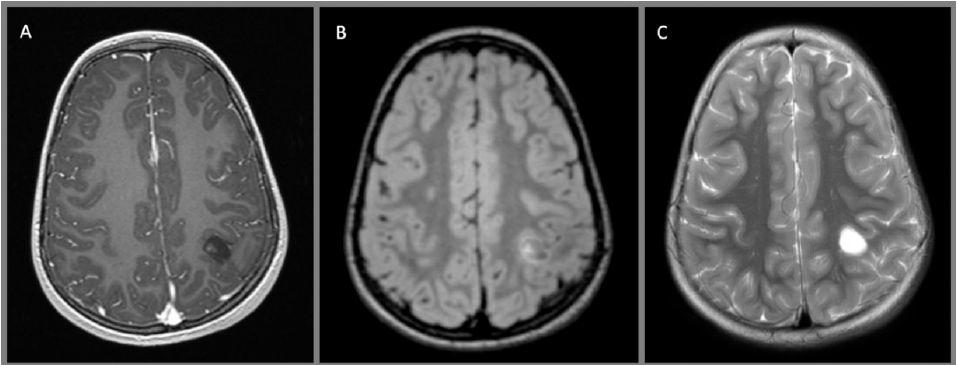
Figure 5. Dysembryoplastic neuroepithelial tumor, WHO I: ( A ) axial T1 MPRAGE with contrast, ( B ) axial T2 FLAIR with contrast, and ( C ) axial T2 without contrast demonstrate a small cystic lesion abutting the central sulcus in the left hemisphere. There is a small nodule and rim of enhancement at the medial aspect of the tumor.